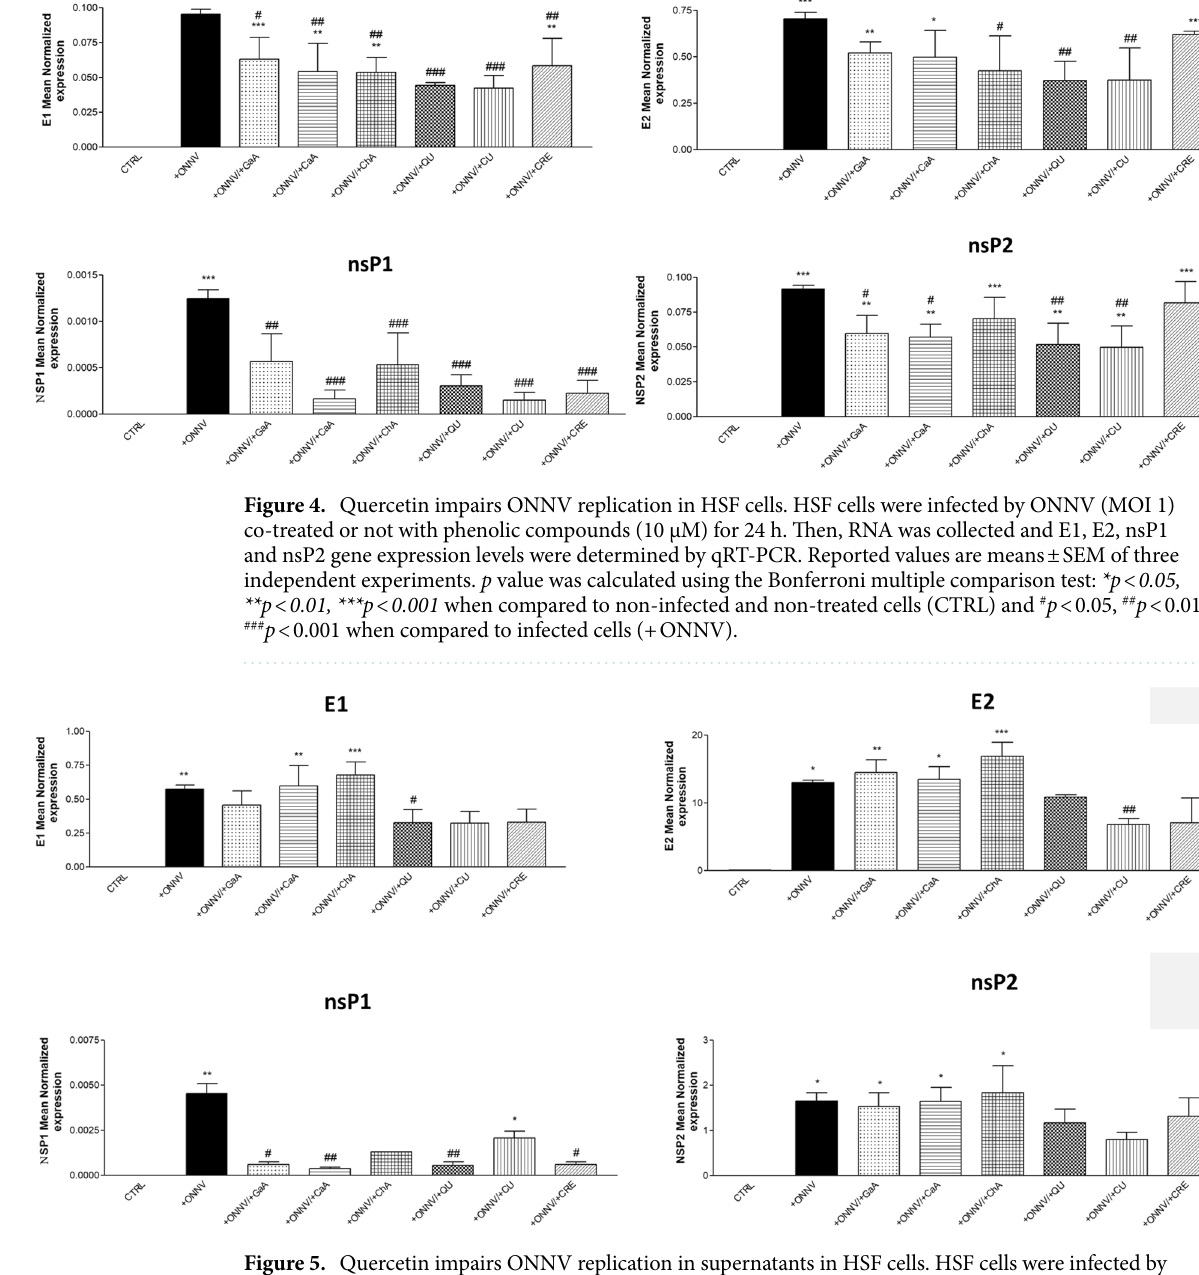
Figure 5. Quercetin impairs ONNV replication in supernatants in HSF cells. HSF cells were infected by ONNV (MOI 1) co-treated or not with phenolic compounds (10 µM) for 24 h. Then, RNA was collected in the supernatants and E1, E2, nsP1 and nsP2 gene expression levels were determined by qRT-PCR. Reported values are means ± SEM of three independent experiments. p value was calculated using the Bonferroni multiple comparison test: *p < 0.05, **p < 0.01, ***p < 0.001 when compared to non-infected and non-treated cells (CTRL) and # p < 0.05, ## p < 0.01 when compared to infected cells (+